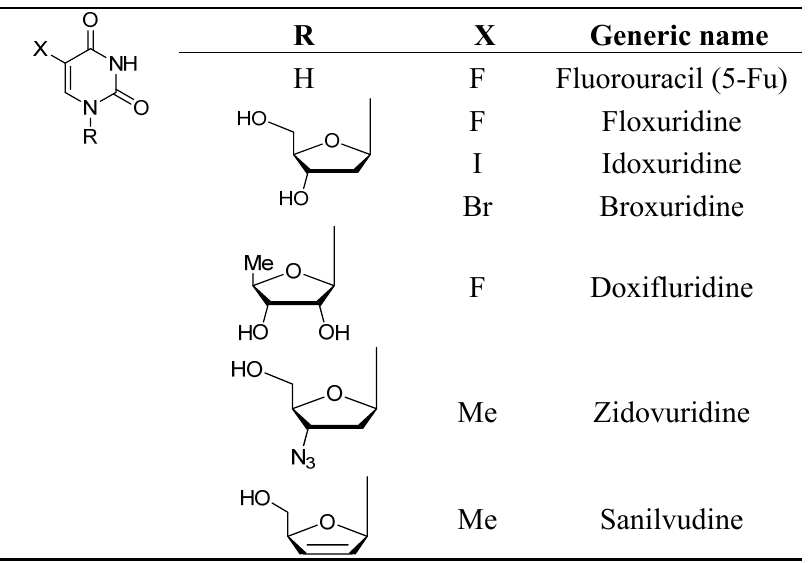
Table 1. Selected biologically active 5-substituted pyrimidine nucleoside